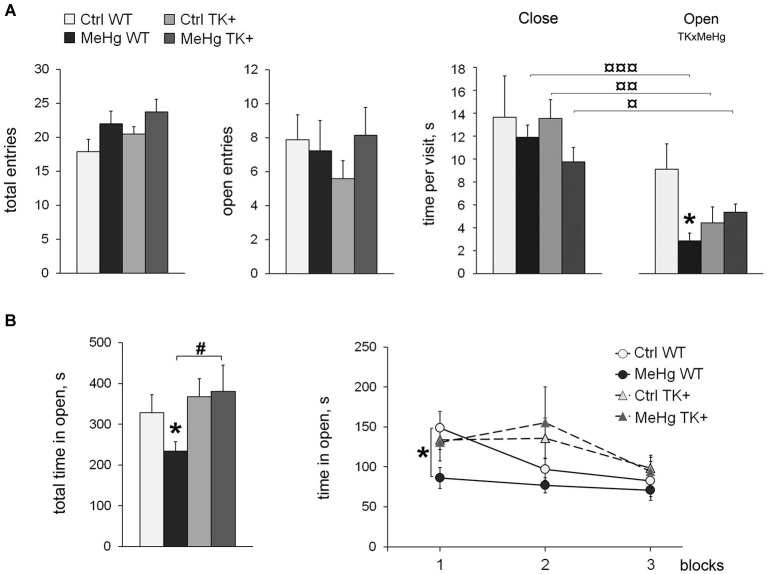
Anxiety-like behavior. (A) Elevated plus maze: the MeHg-exposed mice show increased locomotion, as well as reduced time per visit of the Open arms. All groups except Ctrl WT have decreased time per visit of the Open vs. Close arms; ¤
P < 0.05, ¤¤
P < 0.01, ¤¤¤
P < 0.001 paired two-tailed Student’s t-test. (B) Open field test: the time spent in open arena is shown as total and divided in three 10-min blocks. TK overexpression increases the time in open arena in the MeHg mice. Two-way ANOVA analysis: TK × MeHg significant interaction of the factors TK and MeHg. Post hoc Tukey’s group comparisons: * P < 0.05 MeHg vs. respective Ctrl group; #
P < 0.05 TK+ vs. respective WT group. N = 9 Ctrl WT, 12 MeHg WT, 12 Ctrl TK+ and 7 MeHg TK+ mice.